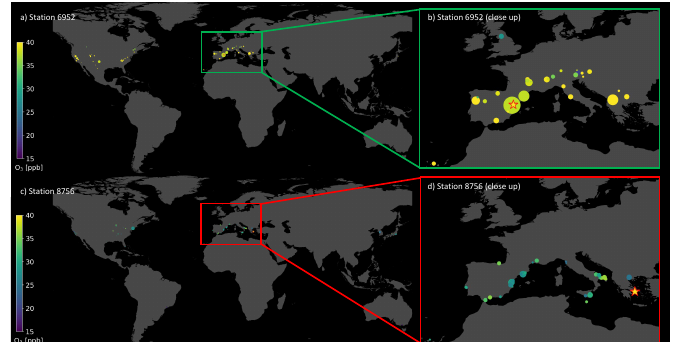
Figure 7. Map with training stations (dots) upon which the trained random forest bases its predictions to predict the test station (star). The colors of the dots indicate the observed ozone value at the respective training and test station. Plot ( a ) and ( b ) depict an accurate prediction with a small residual. Plot ( c ) and ( d ) show an inaccurate prediction with a large residual. Plots ( b ) and ( d ) are close-ups over